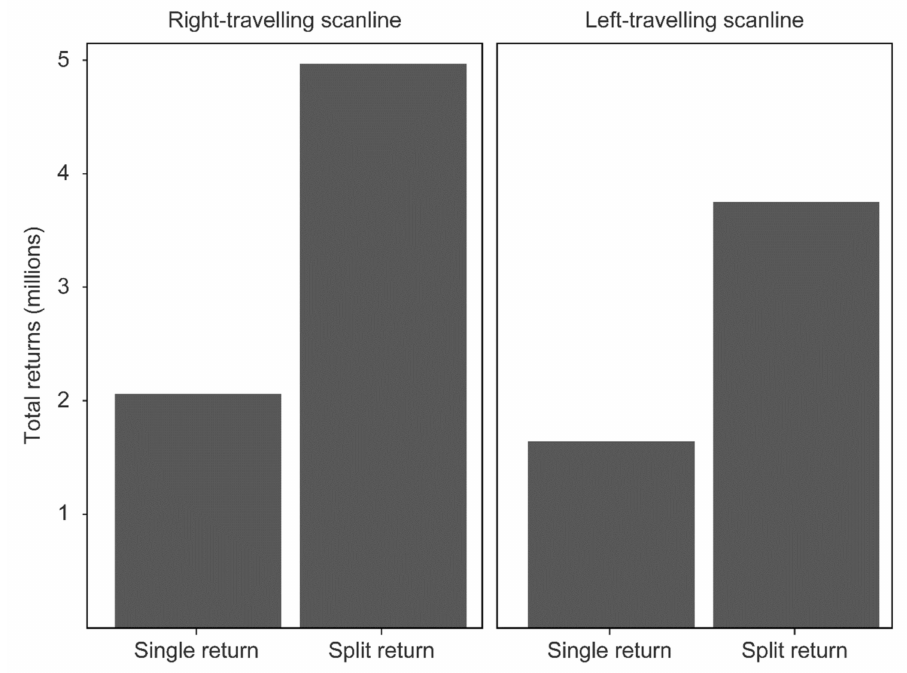
Figure 2. Comparison of return frequency between right-traveling (relative to flight path) and left-traveling scanline